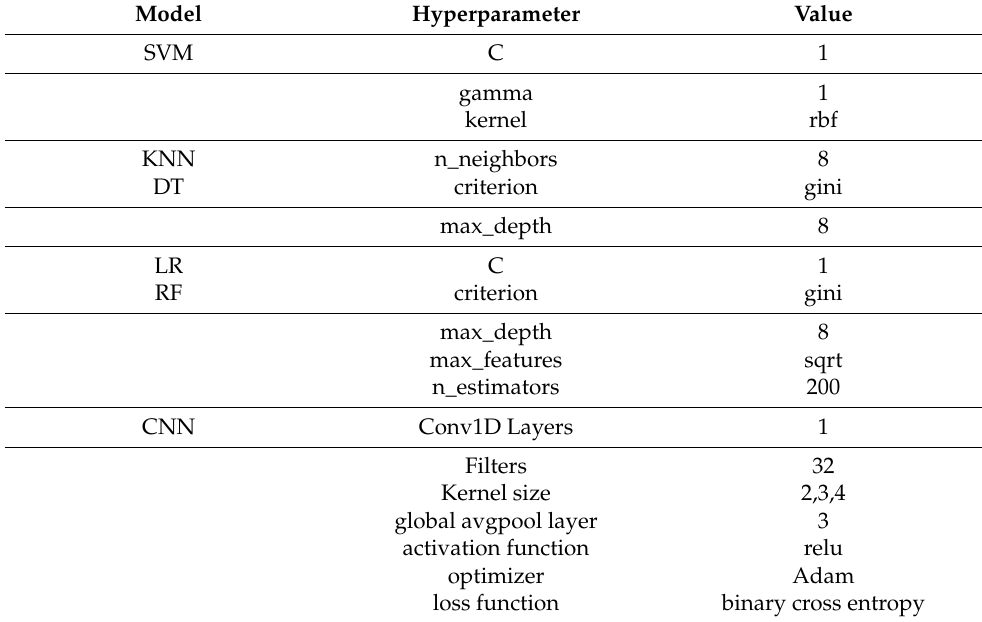
Table 2. Parameter values of different